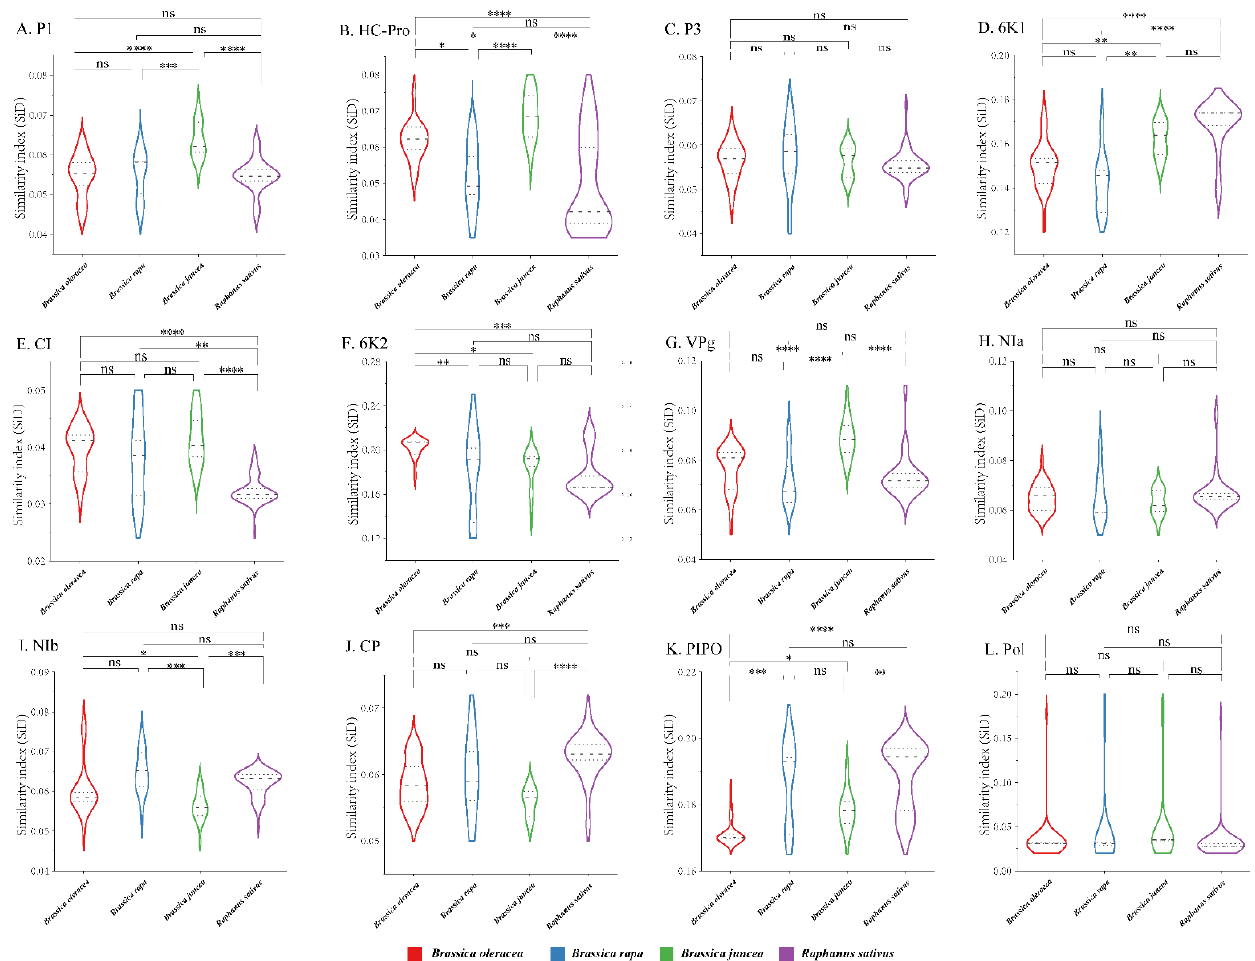
Figure 7. The similarity index (SiD) analysis of the individual protein ( A – K ) and complete polyprotein ( L ) coding sequences of turnip mosaic virus in relation to the natural hosts. One-way ANOVA and Tukey’s test were employed to compare the mean of the SiD values pertaining to the different hosts. Asterisk indicated the differential SiD value of turnip mosaic virus between four hosts is statistically significant or very significant ( p < 0.001 or p < 0.0001), “ns”, not significant, p > 0.05. * p < 0.05; ** p < 0.01, *** p < 0.001; **** p < 0.0001.